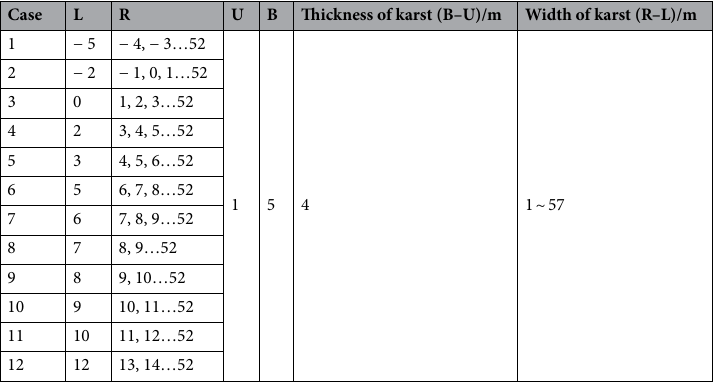
Table 6. Details of the effects of karst width.